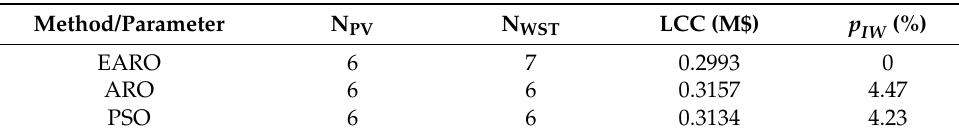
Table 8. System optimization results in the second scenario. Method/Parameter